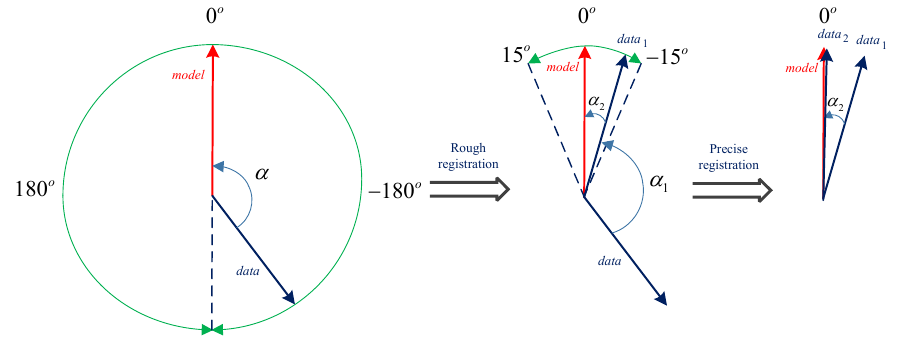
Figure 2. A simple demonstration of the two-stage